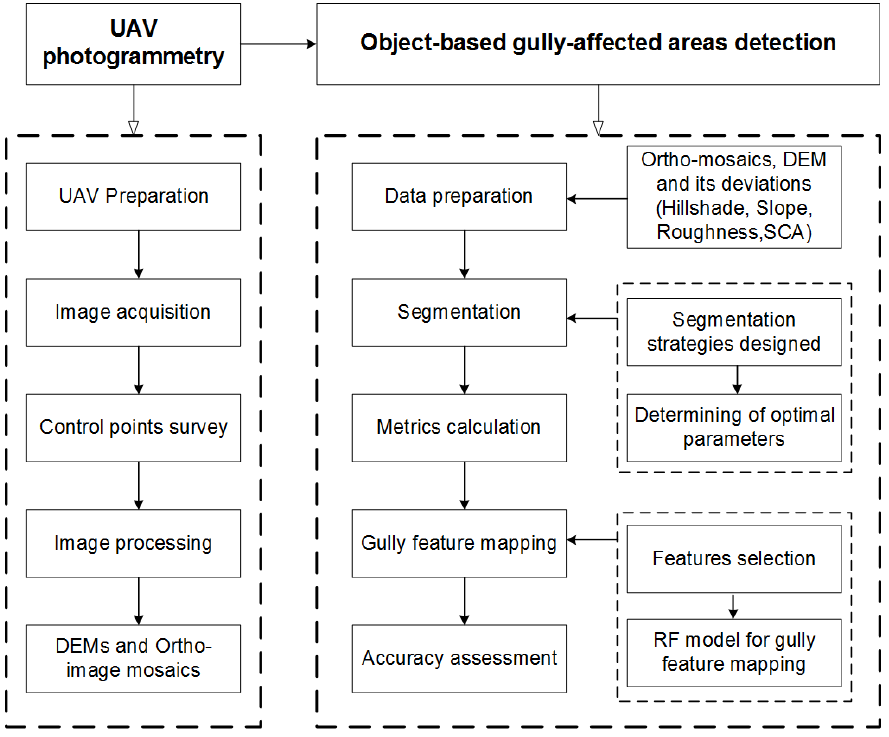
Figure 2. Flowchart of the proposed methodology.